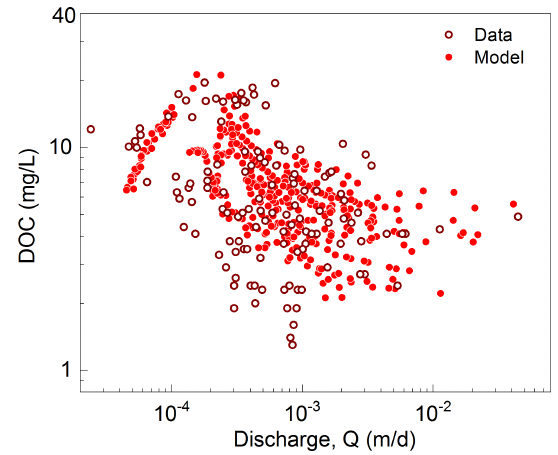
Figure 11. Relationships between daily discharge ( Q ) and stream DOC concentration. With increasing Q , stream flow first shifted from the dominance of groundwater with low DOC at very low dis- charge to the predominance of organic-rich soil water from swales and valley at intermediate discharge. As the discharge increased fur- ther, the stream water switched to the dominance of high flow with lower DOC water from planar hillslopes and uplands, resulting in a dilution C – Q pattern at high discharge (from Wen et al., 2020, used with